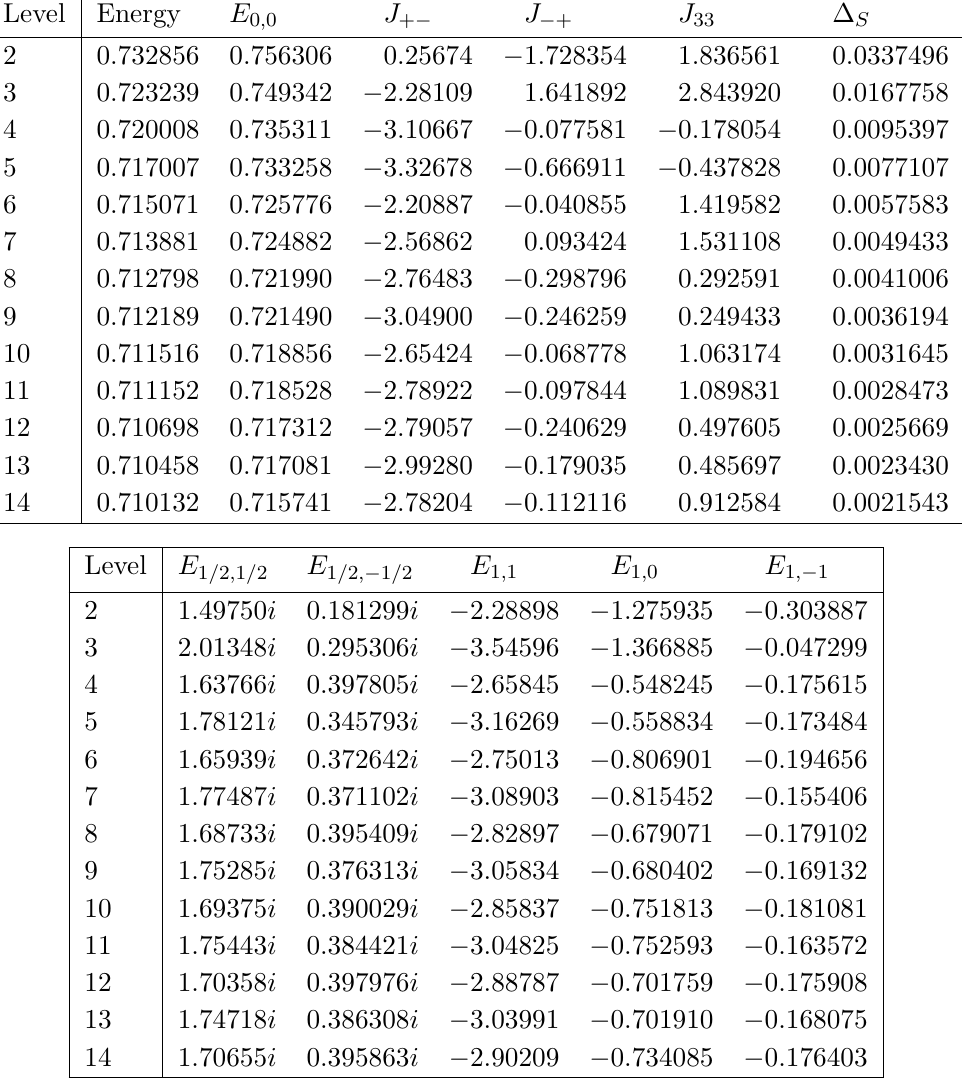
and ρ ≈ 2 . 07 in 2